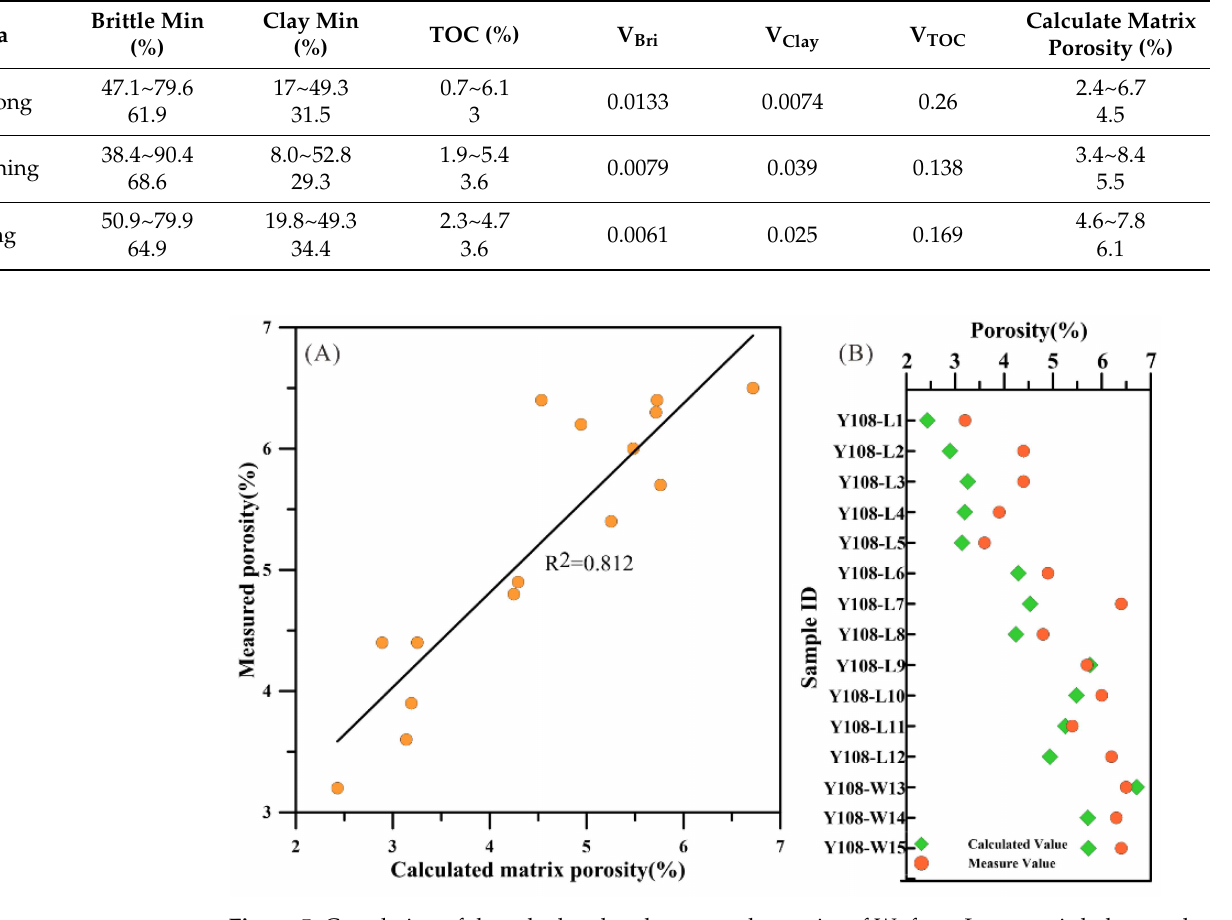
Figure 5. Correlation of the calculated and measured porosity of Wufeng–Longmaxi shale samples. ( A ) Figure of correlation between calculated matrix porosity and measured porosity; ( B ) Comparison of calculated matrix porosity and measured